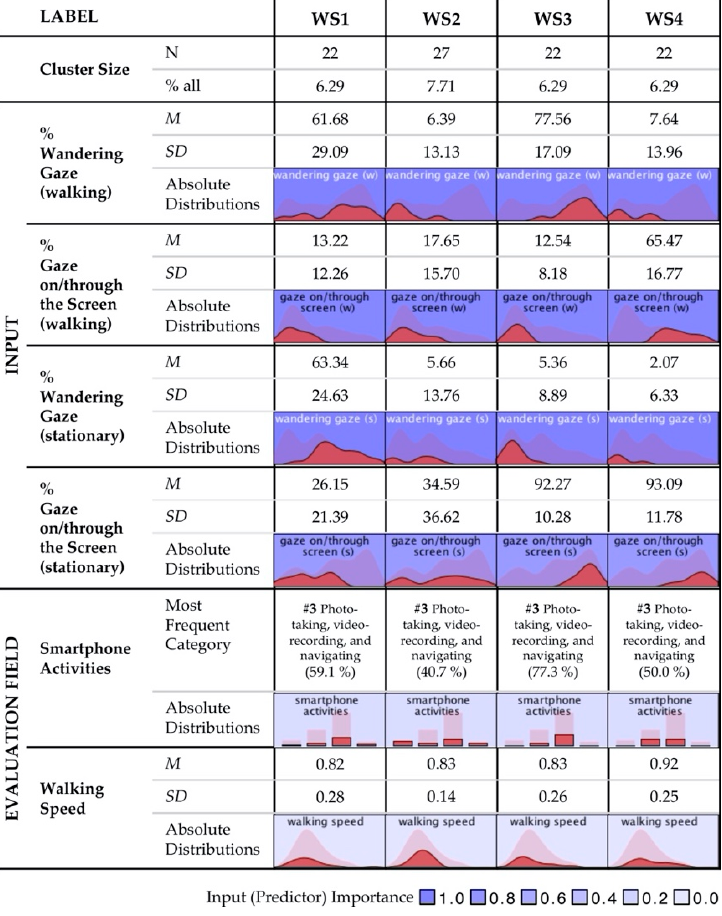
Figure 8. Results of centroids for the smartphone users who stopped along their routes (n = 93). Absolute distribution graphics were generated with SPSS (v25.0). Absolute distribution graphics were generated with SPSS